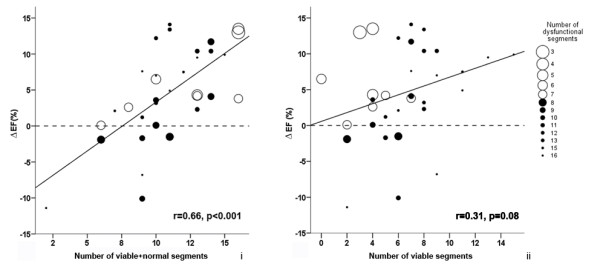
Panel i. Correlation between the number of viable+normal segments and change in EF at 6 months (Δ EF). Panel ii. Scatter plot showing the relationship between the number viable segments and change in EF at 6 months.